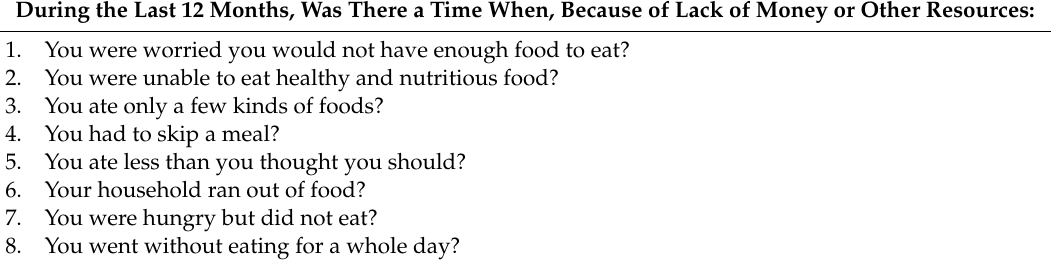
Table 1. Questions in the food insecurity experience scale (the